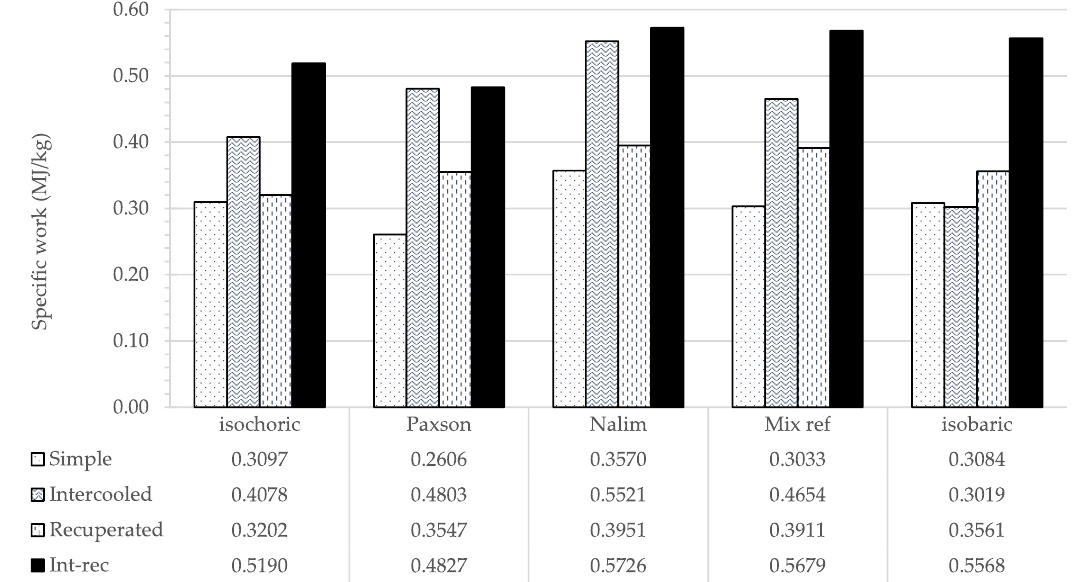
Figure 6. Specific work for various models and